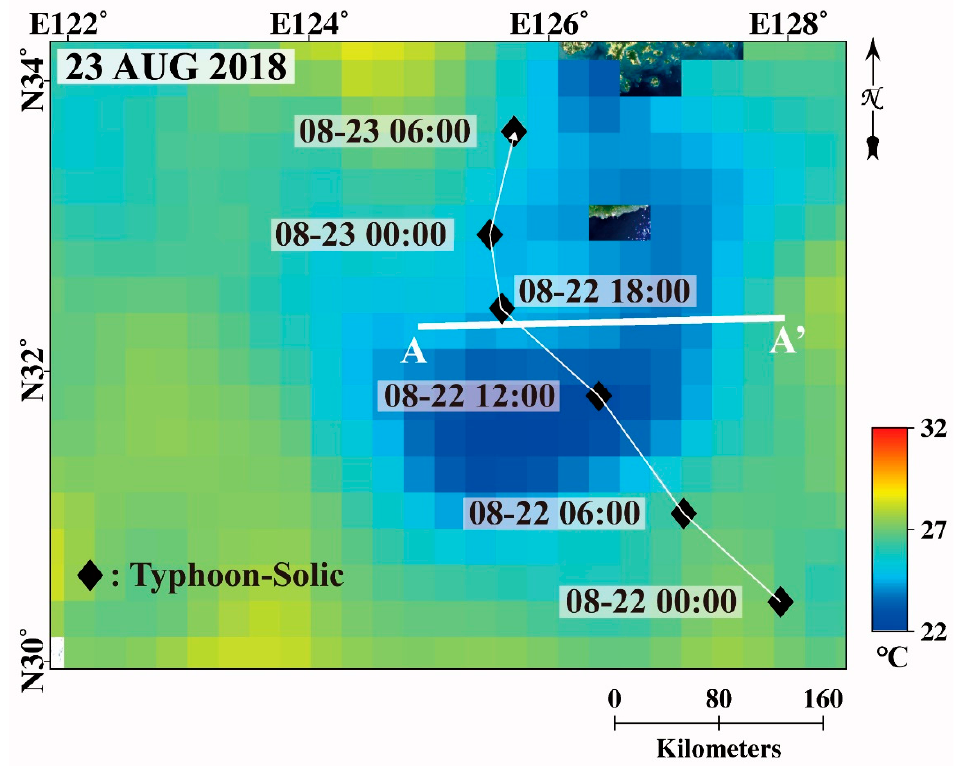
Figure 7. Track of Typhoon Soulik overlaid on NOAA OISST data on 23 August 2018 with the CHL, SSS, and SST profile line (AA’) also shown.